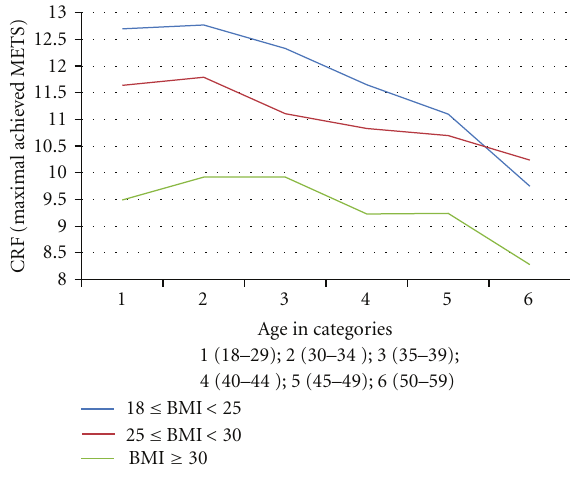
Figure 1: Cardiorespiratory fitness across di ff erent age categories and stratified by BMI categories.